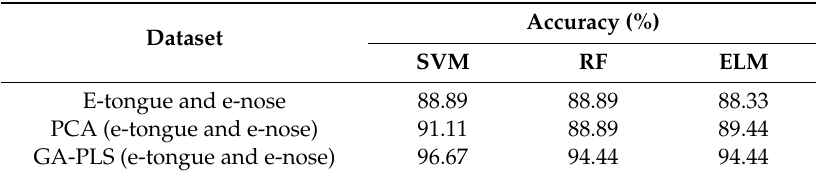
Table 3. Comparison of results for different fusion feature